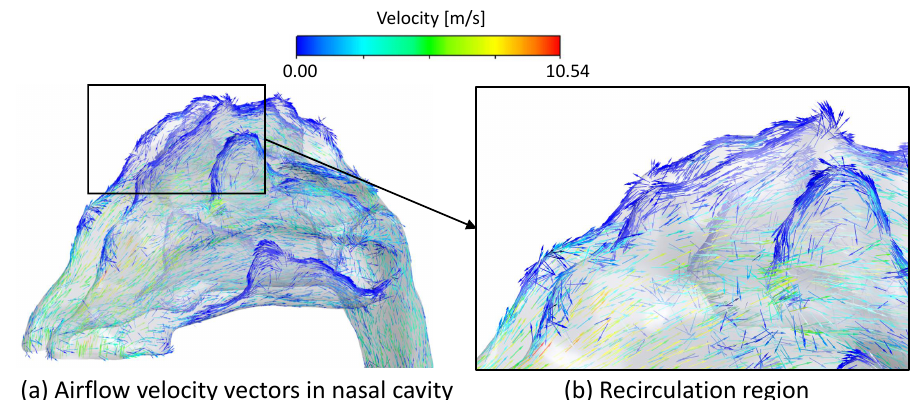
Figure 4. Velocity vectors in the nasal cavity in front of the olfactory region: ( a ) Airflow velocity vectors in nasal cavity, and ( b ) Recirculation region.